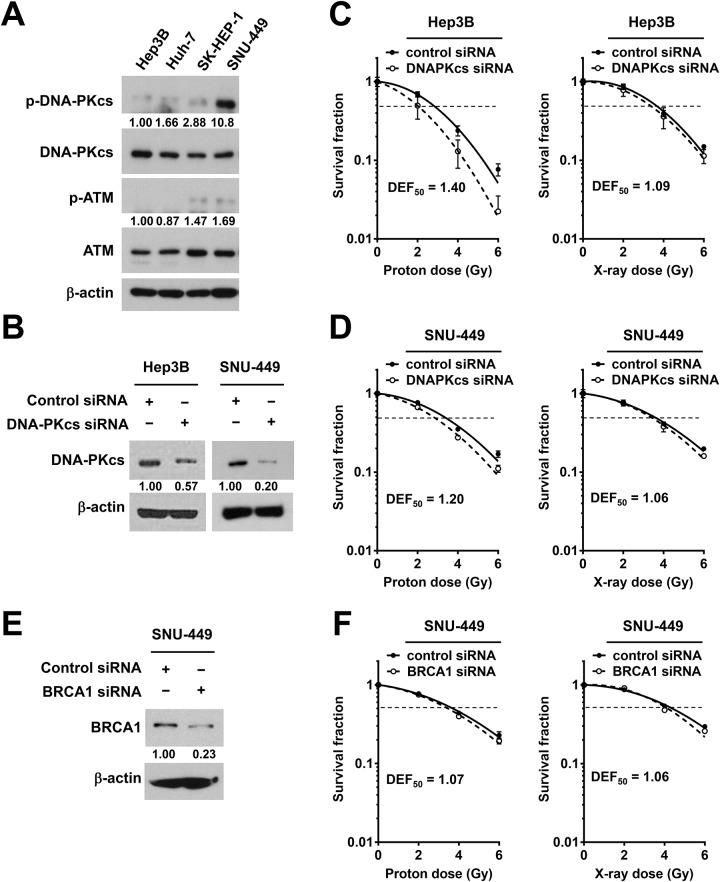
Depletion of DNA-PKcs sensitizes HCC cells to proton irradiation.(A) Detection of basal levels of DNA-PKcs and ATM, and their activated forms among four HCC cell lines. β-actin was used as a loading control. Intensity of phospho-DNA-PKcs and phosphor-ATM bands was normalized to total DNA-PKcs and ATM, respectively. (B) siRNA-mediated knockdown of DNA-PKcs in Hep3B and SNU-449. The cell lysates were prepared 24 h after transfection and were subjected to Western blot analysis. Relative expression of DNA-PKcs in knockdown cells versus control siRNA cells was shown. (C and D) Clonogenic survival assay showed that the depletion of DNA-PKcs by siRNA enhanced proton radiosensitization in Hep3B (C) and SNU-449 (D) cells. (E) Western blotting confirmed siRNA-mediated BRCA1 knockdown in SNU-449 cells. β-actin was used as a loading control. Relative expression of BRCA1 in knockdown cells versus control siRNA cells was shown. (F) Clonogenic assay showed that depletion of BRCA1 did not affect clonogenic survival of SNU-449 cells treated with protons or X-rays. All data represent mean ± SD and the survival curves were fitted to a linear-quadratic model using GraphPad Prism software. DEF50 was calculated as described in Materials and methods.